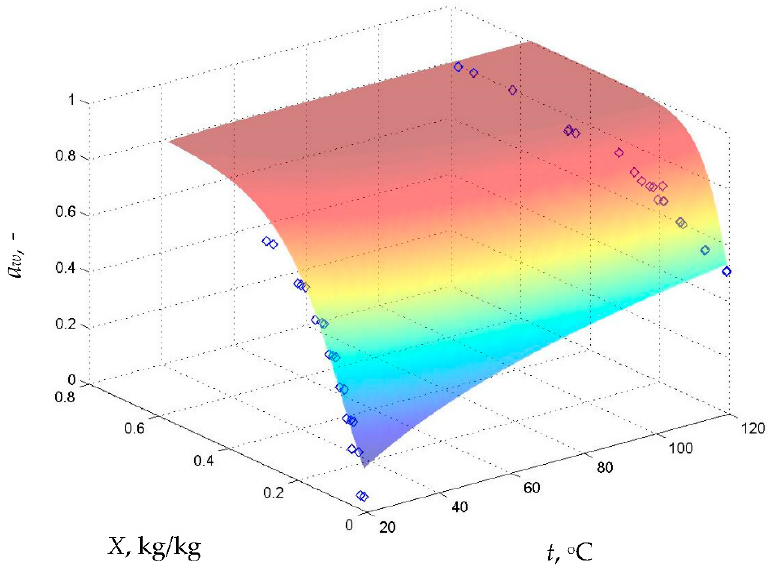
Figure 5. Three-dimensional sorption-equilibrium equation fitted to our experimental results (blue